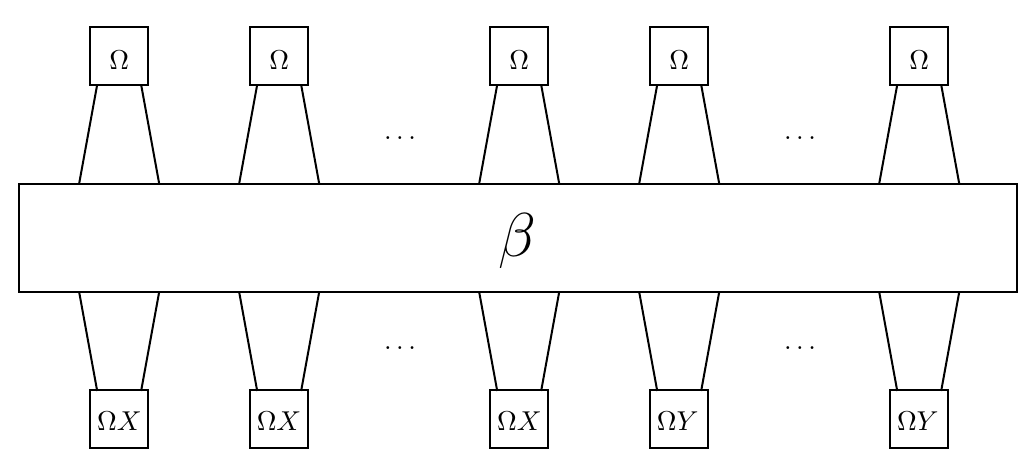
Figure 12 . Diagrammatic representation of the contraction pattern for symplectic mesonic